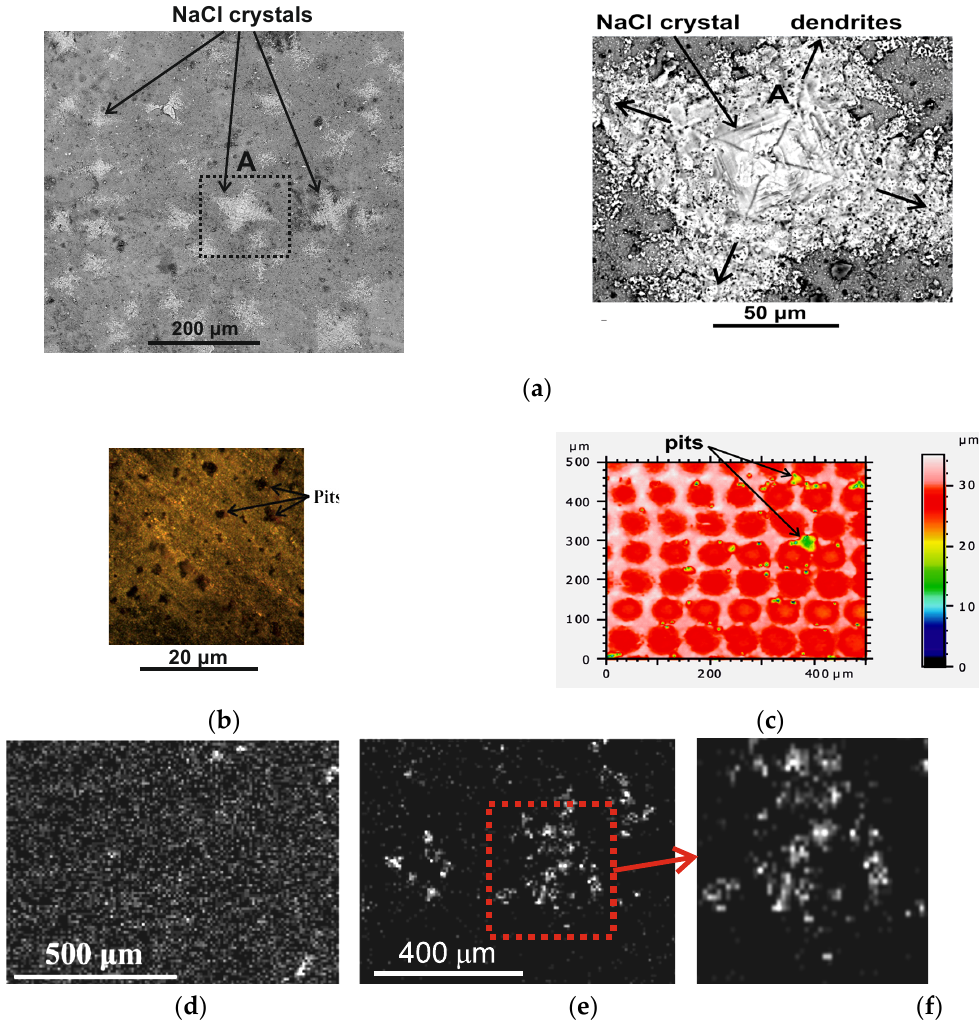
Figure 5. ( a ) The growth of salt crystals on the metal surface in the presence of corrosion. ( b ) The development of pits on the smooth surface (sample 1). ( c ) Pits on the superhydrophilic textured surface. ( d – f ) Carbon distribution over the samples surface (white areas): ( d ) sample 2; ( e ) sample 4; ( f ) magnified